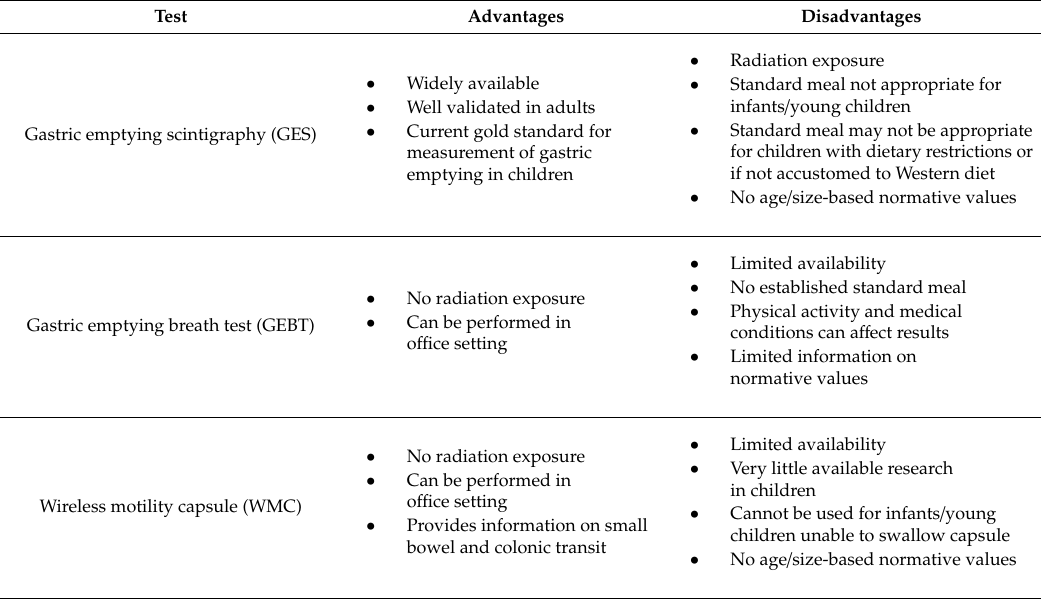
Table 1. Tests used to measure gastric emptying in